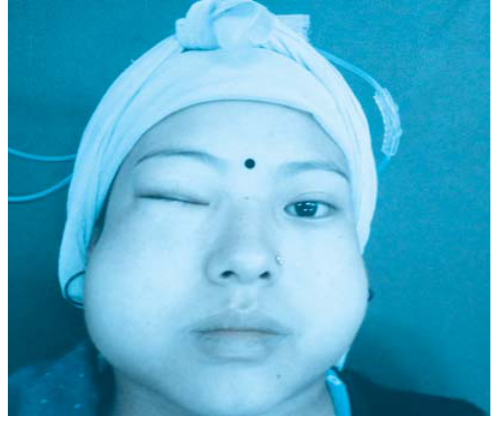
Figure 1. Swelling of the right side of the face The patient came walking comfortably to the emergency room and her vital signs were normal. There was swelling over the right side of chest extending through the neck to the right side of the face (Figure 1). The swelling was non-tender, crackling in palpation and without increase in local temperature. On auscultation of the chest, air entry was equal on both sides. Other systemic examinations were normal.